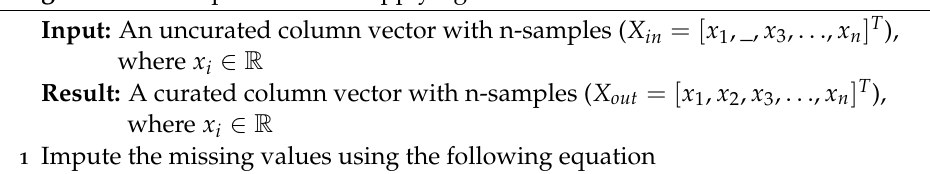
Algorithm 1: The procedure for applying the MVI method